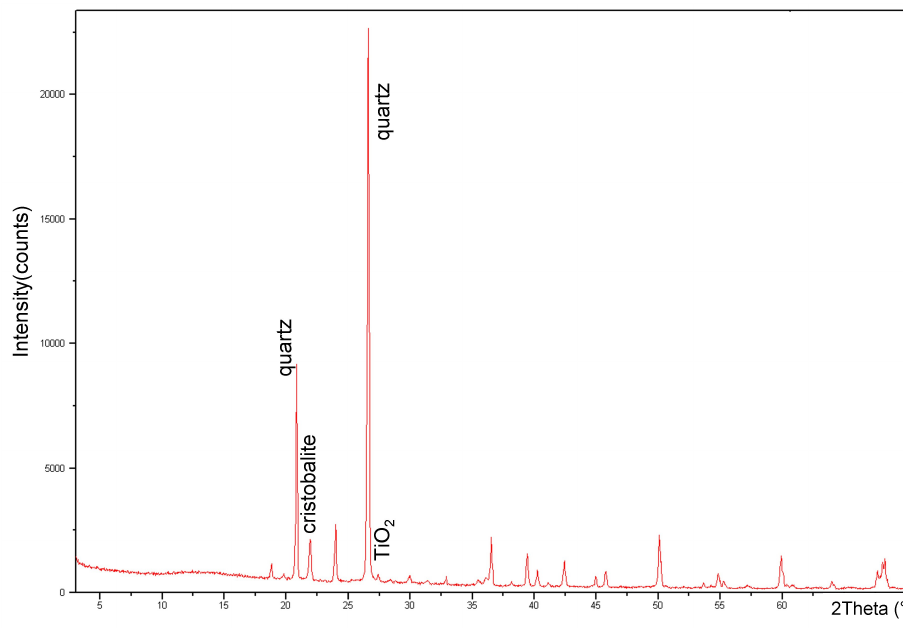
Figure 4. XRD of the starting inorganic deltamat